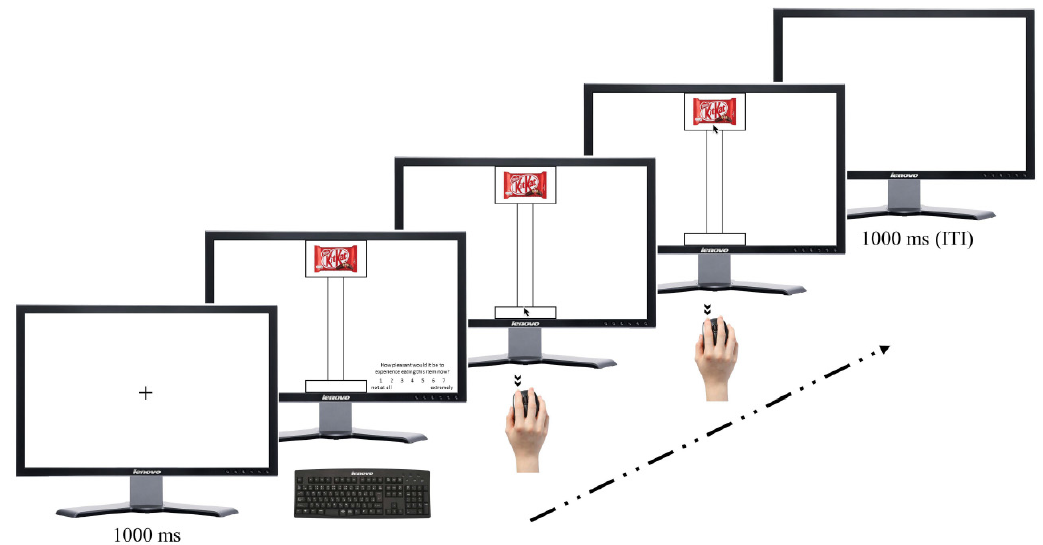
Figure 2. Schematic representation of the experimental trial sequences. Participants had to imagine, in a first-person perspective, dragging the mouse along the path, from the starting point to the food item picture in the upper rectangle at the end of the path. They had to press the left mouse button with the index finger of the right hand to signal the start of their imagined movement, and the button had to be pressed again to flag the imagined reaching of the food item. Trials were separated by a 1000 ms inter-trial interval (ITI) with a blank